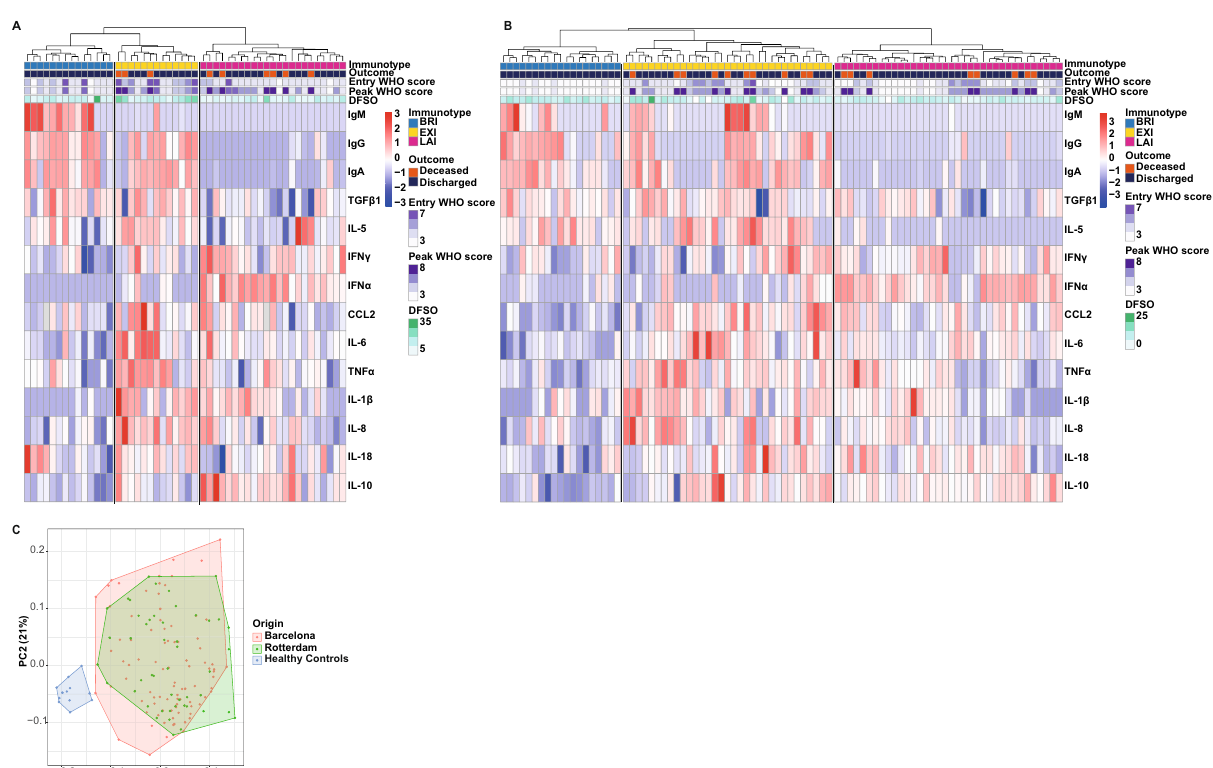
Fig. 1 Unsupervised hierarchical clustering identi fi es three distinct immunotypes in acute COVID-19 patients. Applying machine learning by unsupervised hierarchical clustering solely to serum cytokines and anti-SARS-CoV-2 antibodies identi fi es three distinct immunotypes. Analysis was performed on samples collected at study entry and without clinical data input. The three immunotypes, identi fi ed independently in two patient cohorts, are depicted in A the heat map of the Rotterdam discovery cohort ( n = 50) and B the heat map of the Barcelona validation cohort ( n = 88) using row-based log-transformed z -scores. C Principal component analysis (PCA) of serum cytokines and anti-SARS-CoV-2 antibodies shows that both Rotterdam and Barcelona cohorts cluster together while they lie apart from healthy controls. The fi rst two components with their percentage of variance are shown in parentheses. Red-blue color depicts z -scores. Top banners of heatmaps show: immunotypes BRI, EXI and LAI, WHO clinical score at entry and the peak during hospitalization, patient death and discharge, and days from symptoms onset